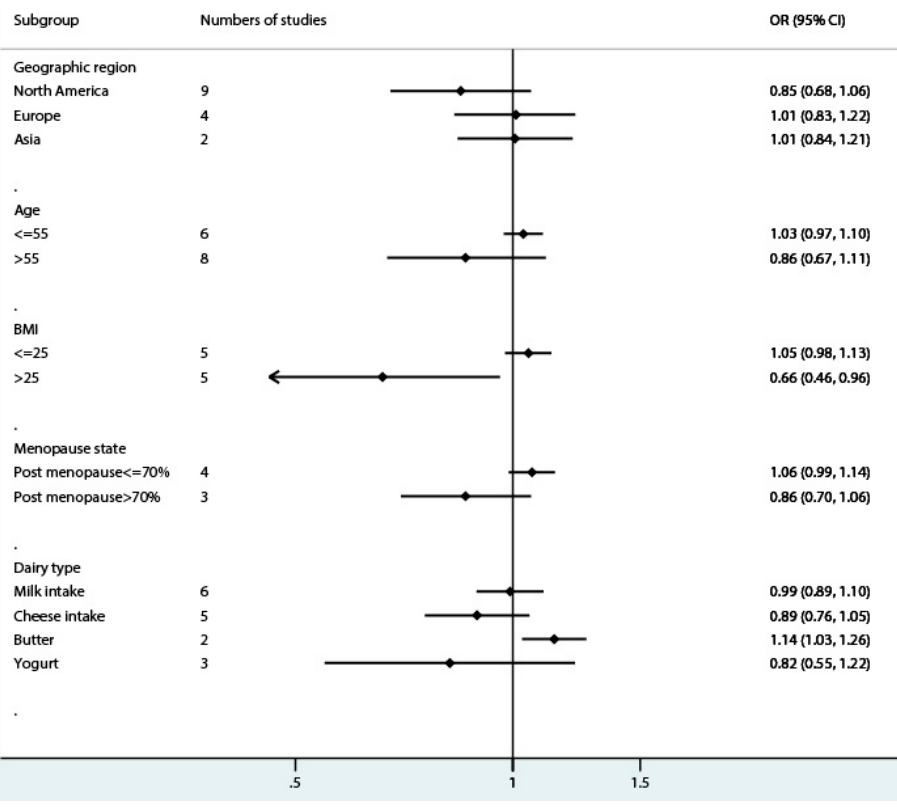
Figure 6. Subgroup analysis of the forest plot of the risk estimate of endometrial cancer comparing the highest category of dairy intake with the lowest category. OR, odds ratio; CI, confidence interval; BMI, body mass index.